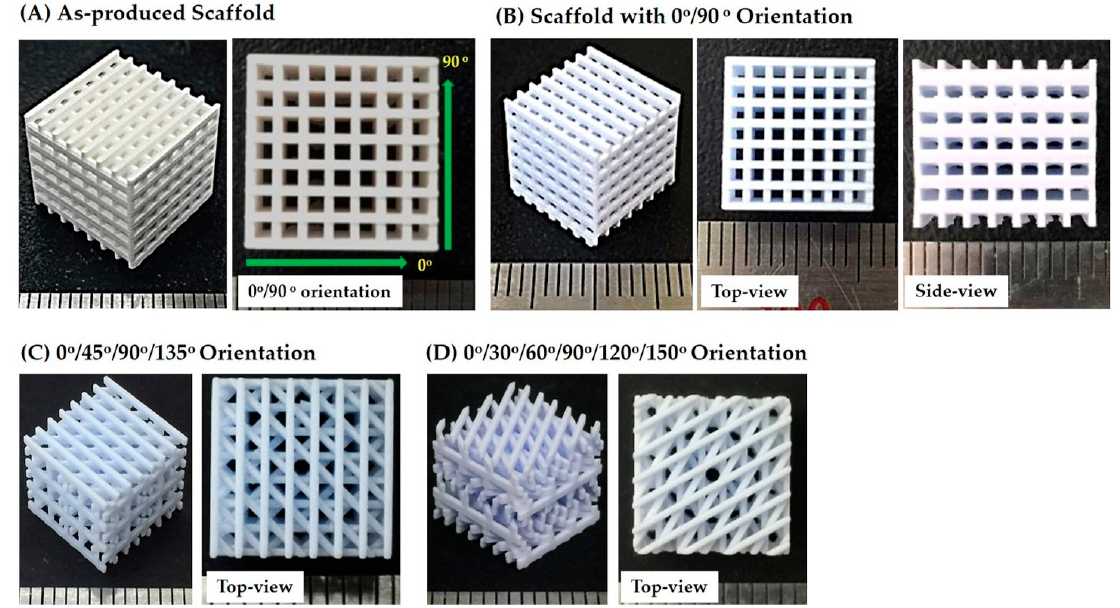
Figure 8. Optical images of ( A ) the as-built CaP scaffold showing its overall porous structure and the construction of straight CaP frameworks in in a 0°/90° orientation and the porous CaP scaffolds after sintering at 1250 °C for 3 hours, which have different pore orientations of ( B ) 0°/90°, ( C ) 0°/45°/90°/135°, and ( D ) 0°/30°/60°/90°/120°/150° (scale = 1 mm).